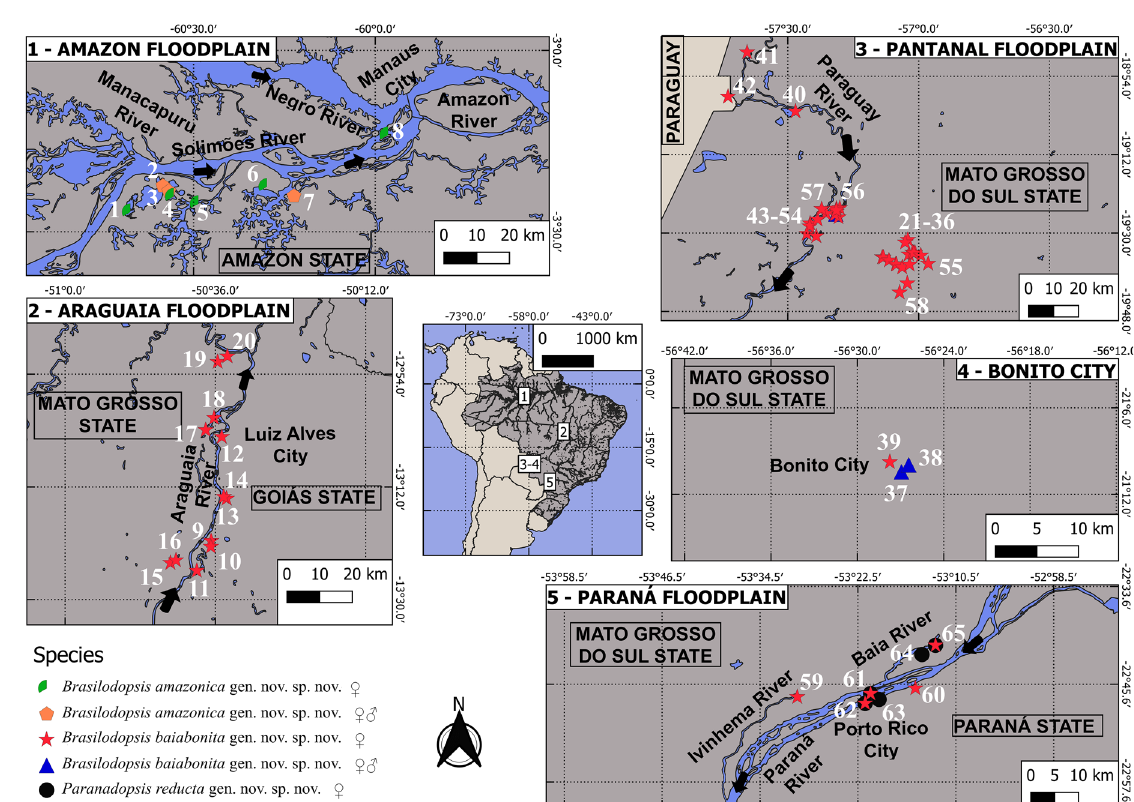
Fig. 1. Localities where Brasilodopsis amazonica gen. et sp. nov., Brasilodopsis baiabonita gen. et sp. nov. and Paranadopsis reducta gen. et sp. nov. were found. Locality names are in